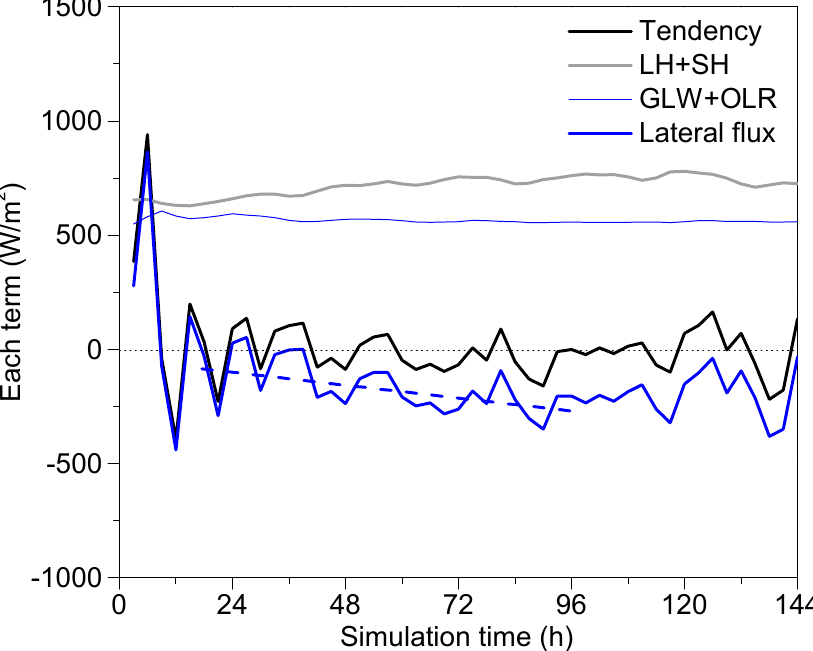
Figure 11. Time evolution of all terms comprising volume-integrated, mass-weighted MSE budget.